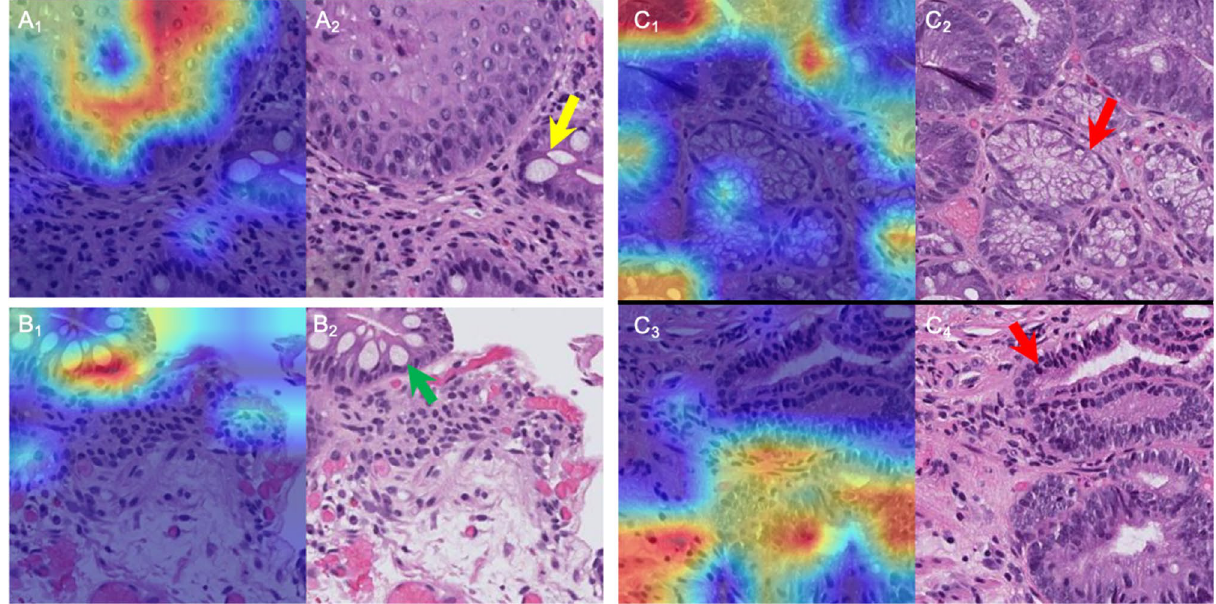
Figure 4. Gradient-weighted Class Activation Maps (Grad-CAMs) that highlight regions of biopsy images that are relevant to classification by the deep learning model (hematoxylin and eosin stain, 40 × magnification). Red/orange coloration indicates high activation while blue/green coloration indicates low activation. Created using matplotlib 3.3.2 (https ://matpl otlib .org/). ( A ) Grad-CAM (A 1 ) and corresponding biopsy patch (A 2 ) for an example of squamous tissue abutting intestinal tissue. The model clearly shows the highest activation in the squamous area while showing lower activation in the surrounding intestinal-like tissue with visible goblet cells (yellow arrow). ( B ) Grad-CAM (B 1 ) and corresponding biopsy patch (B 2 ) for an example of non-dysplastic Barrett’s. Here, the model shows the highest activation in the intestinal-like tissue with visible goblet cells (green arrow) and low activation in the surrounding connective tissue. ( C ) Grad-CAMs (C 1 and C 3 ) and corresponding biopsy patches